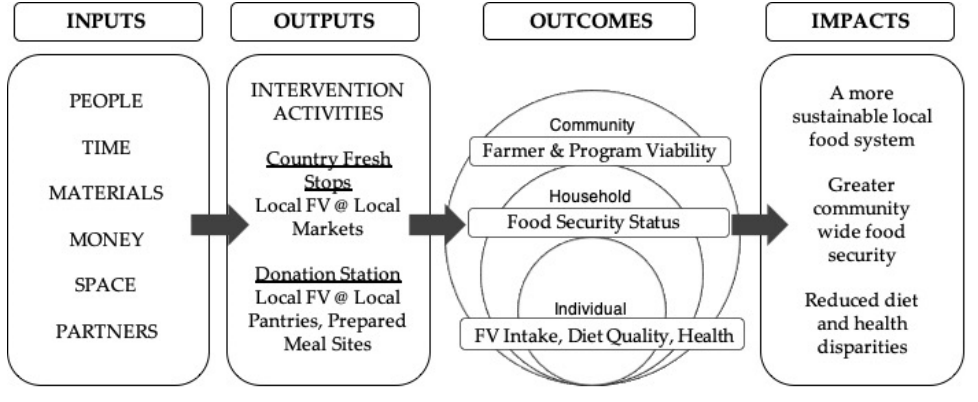
Figure 2. Programmatic logic model.